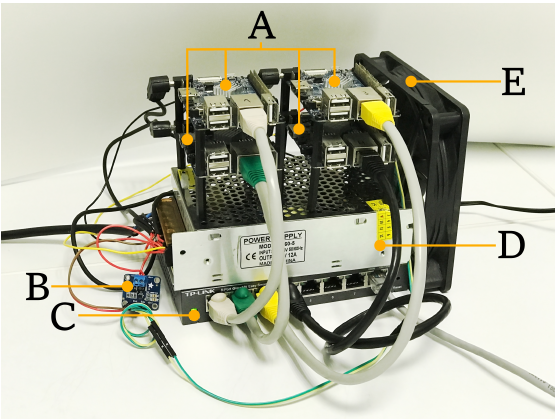
Figure 5. Testbed. ( A ) Orange Pi PC Single Board Computers (SBCs); ( B ) INA219; ( C ) switch; ( D ) power